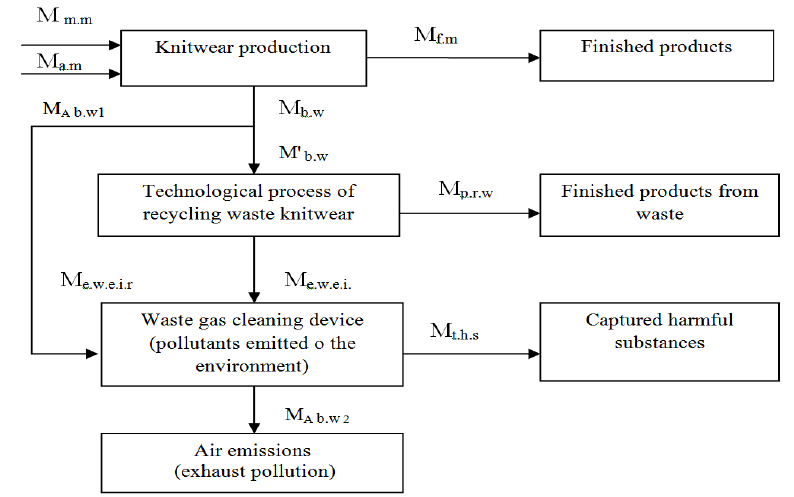
Fig. 1. Scheme of material balance processing waste knitwear